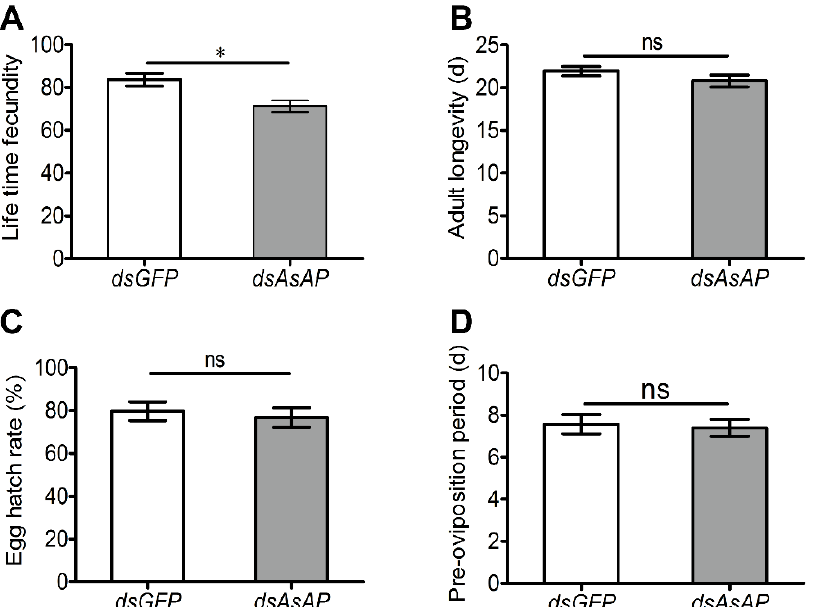
three independent biological replicates. Asterisks indicate statistical significance (** p < 0.01 and *** p < 0.001, according to Student’s t-tests).